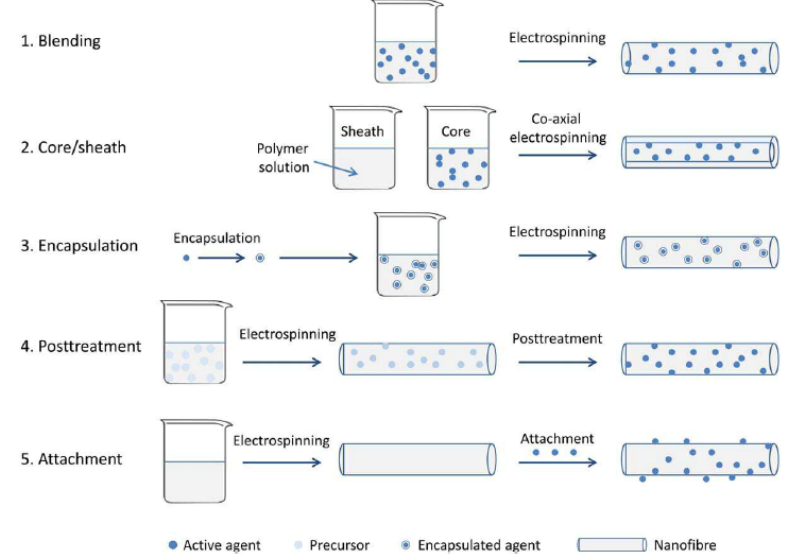
Figure 2. Various methods of incorporating biocides into electrospun nanofibers. ( 1 ) blending/dispersion of the active agent in the polymer solution prior to electrospinning; ( 2 ) confinement of the active agent in the core of the fiber through co-axial electrospinning; ( 3 ) encapsulation/adsorption of the active agent in nanostructures before dispersion in the electrospinning solution; ( 4 ) conversion of a precursor to active agent in the nanofibers after electrospinning; and ( 5 ) attachment of the active agent onto the nanofibers after electrospinning. Reprinted from Reference [71], Copyright 2014, with permission from John Wiley and sons.